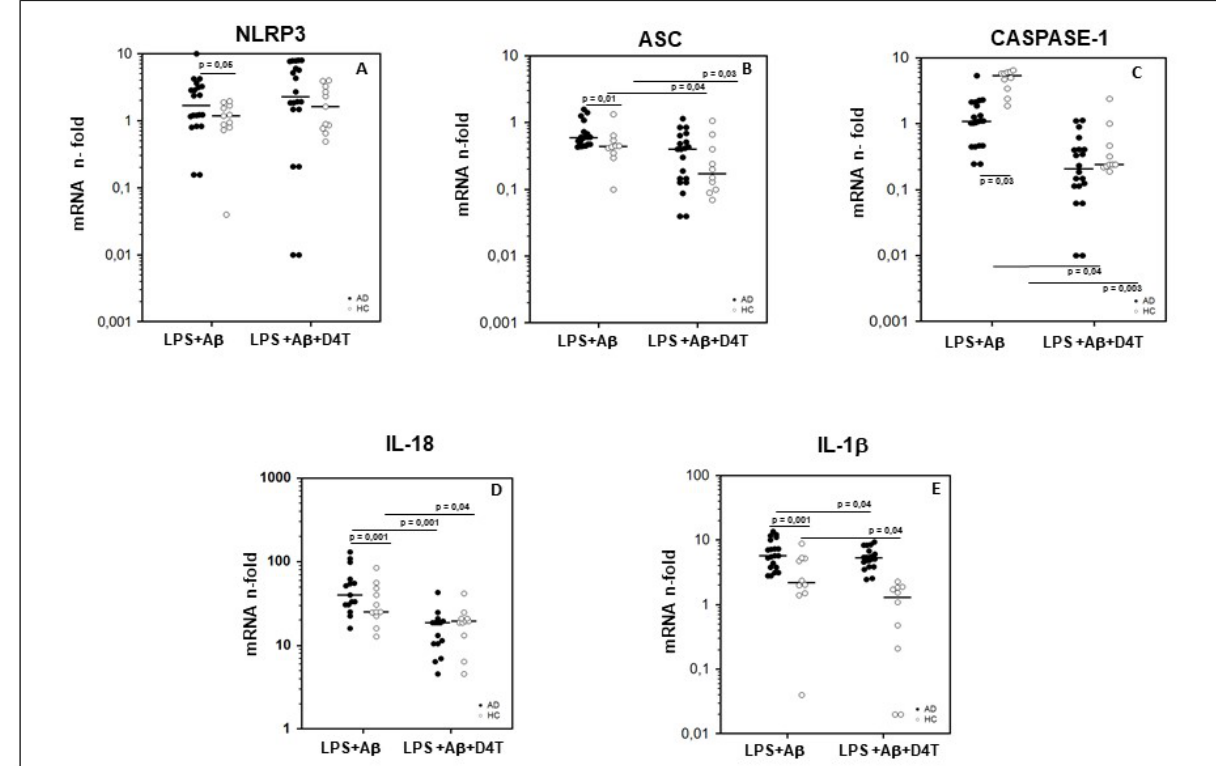
Figure 1. Genes of inflammasome complex. Expression of mRNA for Nod-like receptor protein 3 (NLRP3) ( A ), ASC ( B ), caspase-1 ( C ), IL-18 ( D ), and IL-1 β ( E ) is shown. Results were obtained after the samples were primed with lipopolysaccharide (LPS) (1 µ g/mL) and stimulated with A β 42 (10 µ g/mL) in the presence/absence of D4T (Stavudine) (50 µ M) PBMC of AD (black dots) patients and Healthy Controls (HC) (white dots). Summary results are shown in the dots-plot-graphs and are expressed as the fold change (n-fold) between results obtained in stimulated cells/medium (unstimulated cells). NLRP3, ASC, Caspase-1, IL-18 and IL-1 β gene expression was calculated relative to the GAPDH housekeeping gene. Horizontal bars indicate medians. Statistical significance is shown.